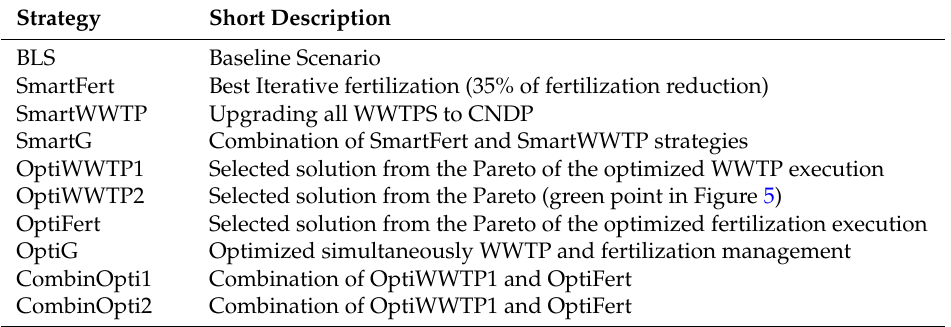
Table 5. Short description of the management strategies